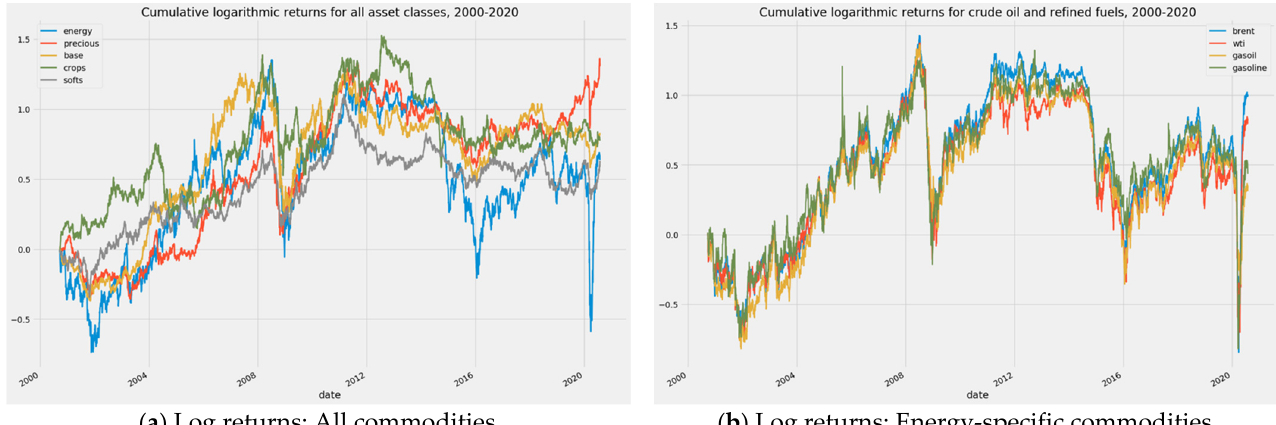
( a ) Log returns: All commodities ( b ) Log returns: Energy-specific commodities Figure 2. Cumulative logarithmic returns: ( a ) All classes of commodities; ( b ) Crude oil and refined fuel markets.